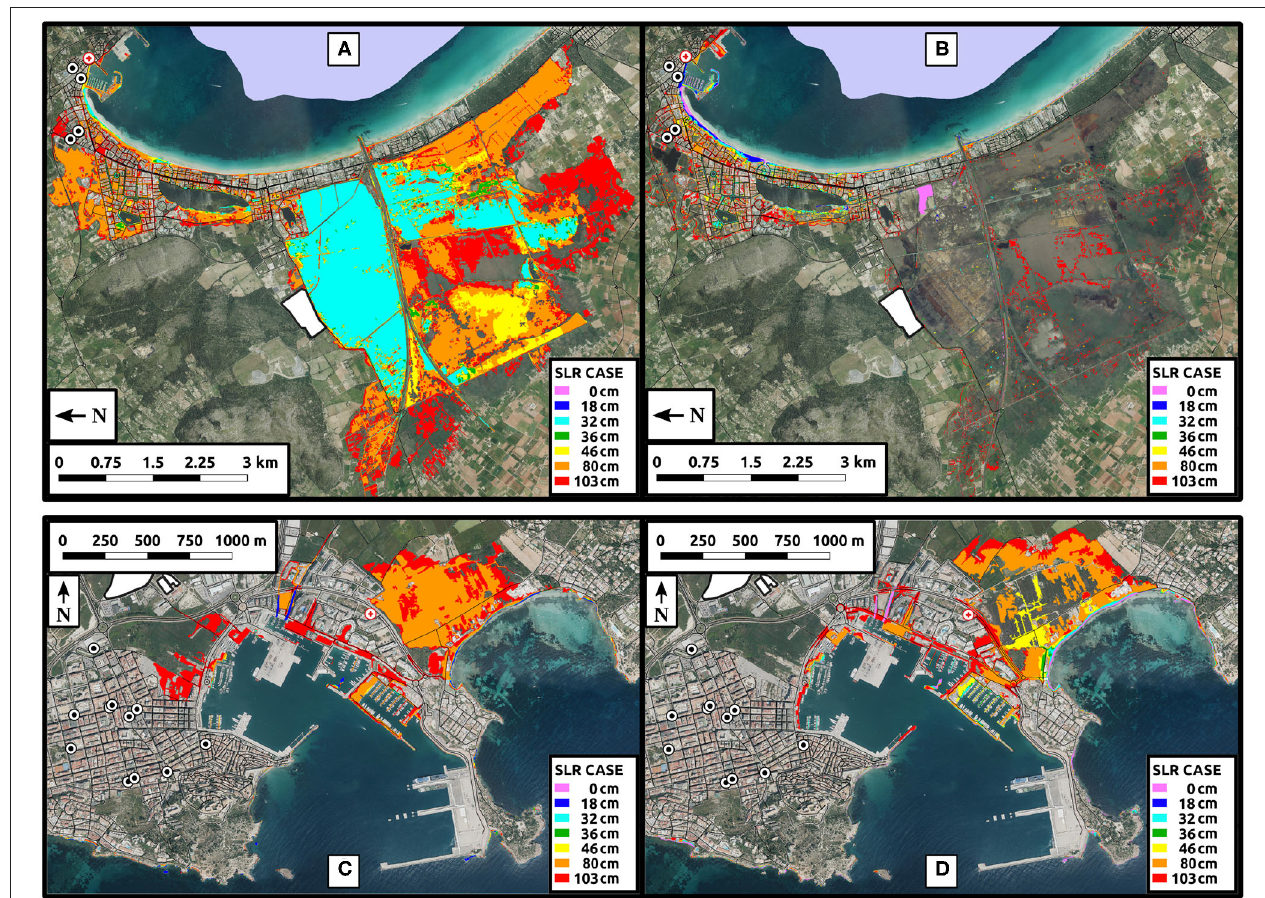
FIGURE 9 | Permanent and extreme flooding extent over the Alcúdia wetland (A,B) and city of Eivissa (C,D) . Roads and streets are marked using black lines. Education facilities are indicated as black dots, sanitary buildings as red crosses, and energy production plants as white polygons.